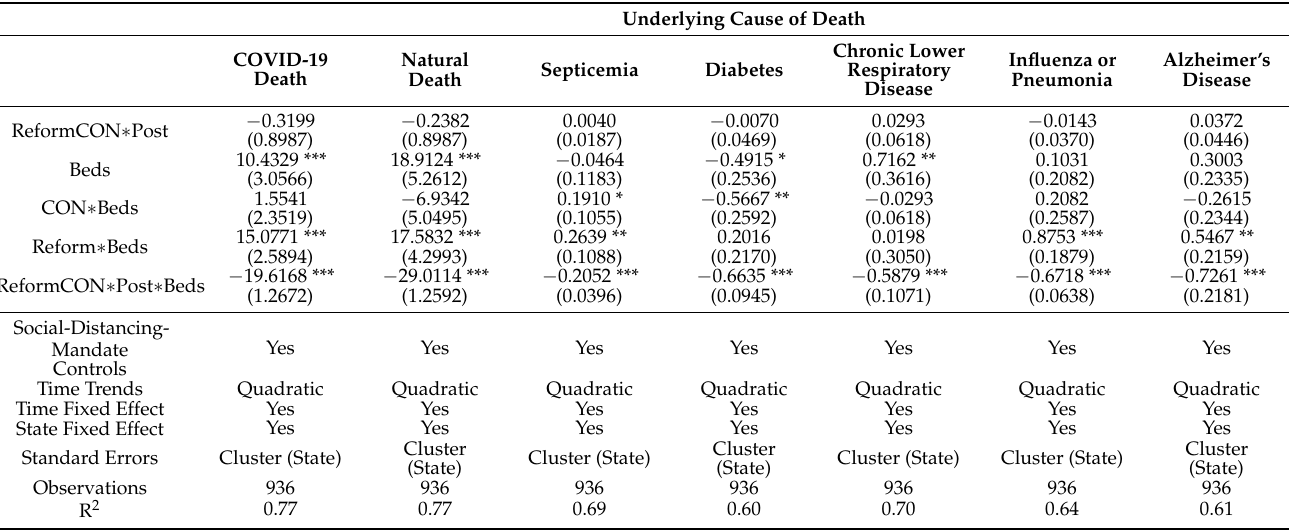
Underlying Cause of Death